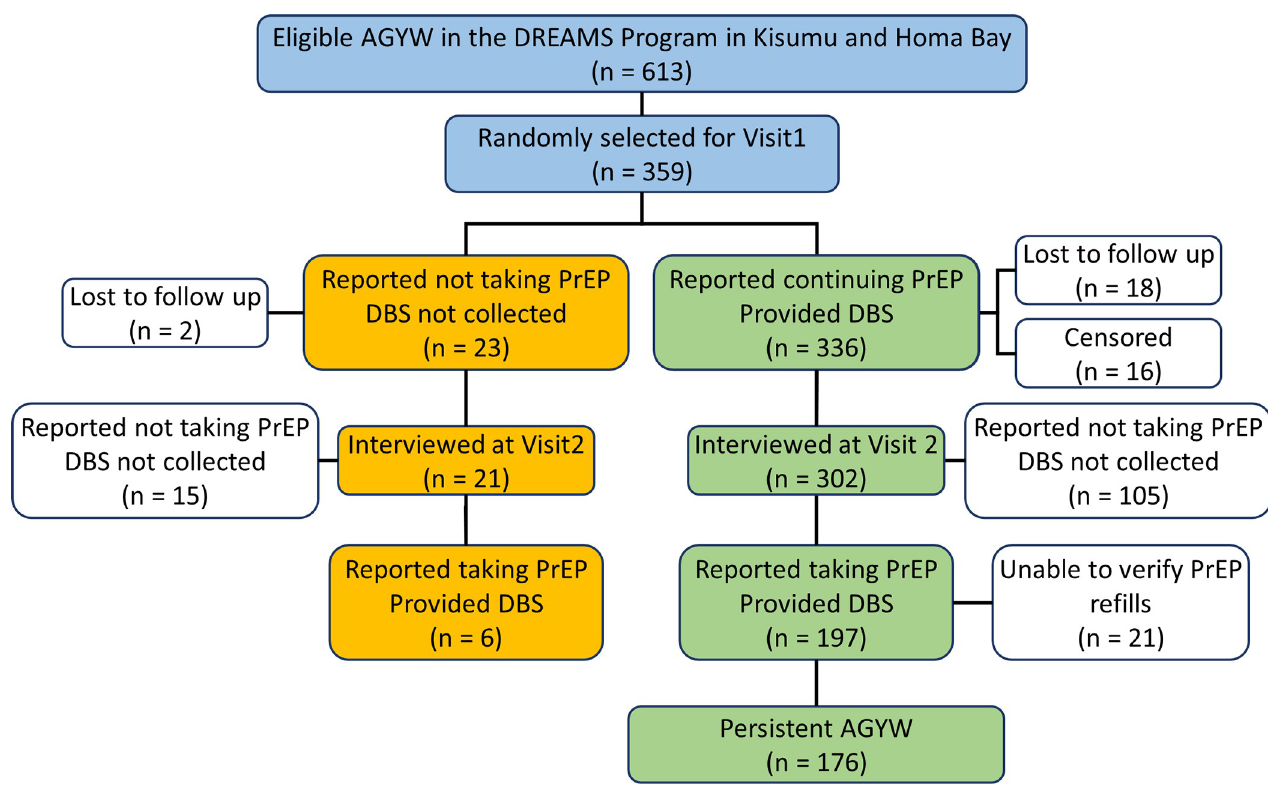
Fig 1. AU : AbbreviationlistshavebeencompiledforthoseusedinFigs 1 and 2 : Pleaseverifythatallentriesarecorrect : Study flow chart showing study design and the attrition of participants at each step of the analysis. Most (246/302, 81%) AGYW interviewed at follow-up had attended at least 1 PrEP dispensation visit between the 2 interviews. Fifty-six had no record of attendance at interim PrEP refill visits, including 21 of the 197 AGYW who reported they were continuing PrEP. This left 176 of the AGYW who attended Interview 2 who met our definition of PrEP persistence (176/302, 58.3%, [95% CI 52.7–63.8] (Figs 1 and 2A and Table A in S1 Table). AGYW, adolescent girls and young women; CI, confidence interval; DBS, dried blood spot; PrEP, pre-exposure